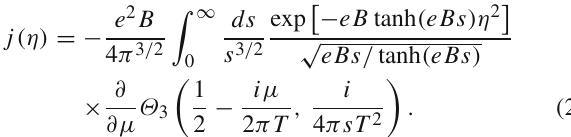
Fig. 4 Behavior of j (η) as a function of T / √ | eB | = π/ 40. The solid (black) curve corresponds to the and μ/ numeric expression in Eq. (19). The long-dashed (red) curve corre- sponds to the weak field approximation in Eq. (21). The short-dashed (blue) curve corresponds to the strong field approximation in Eq.